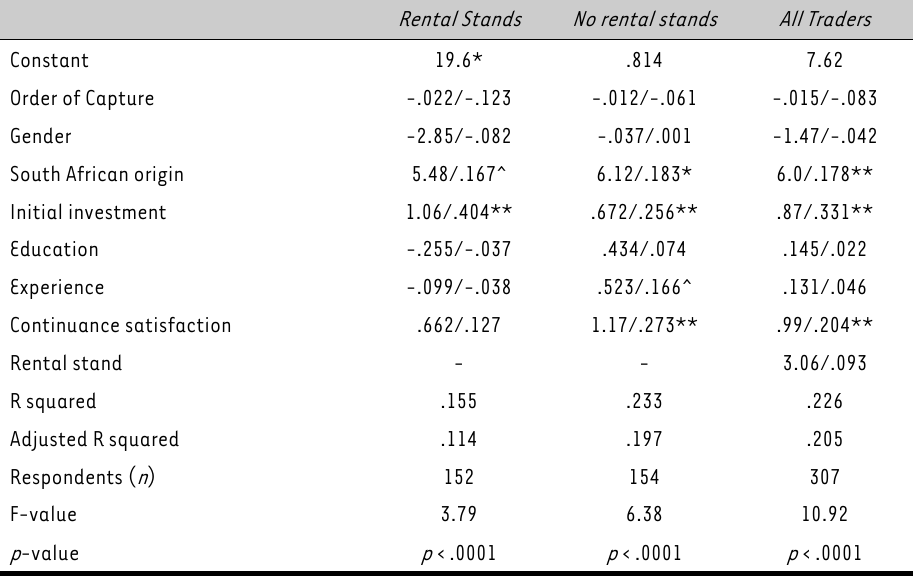
TABLE 3: Multiple Linear Regression Results, 2009